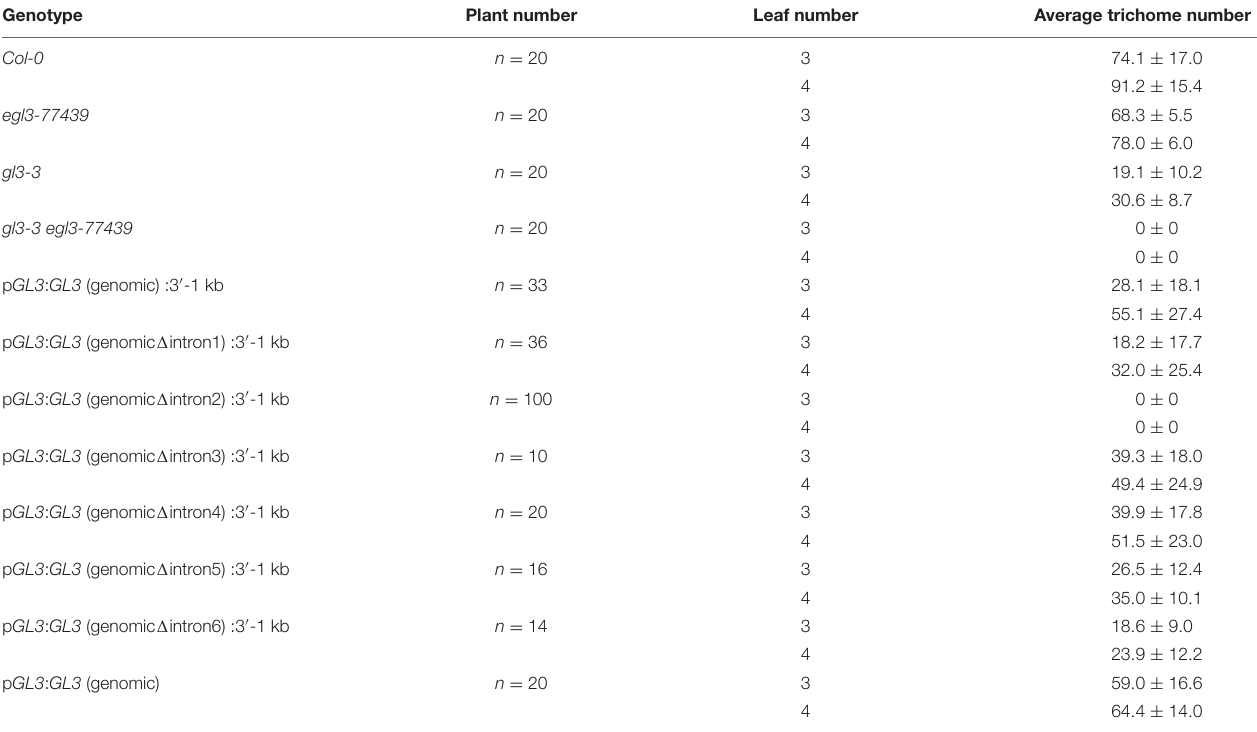
TABLE 1 | Trichome number of the third and fourth true leaf in gl3-3 egl3-77349 mutants transformed with different GL3 rescue constructs. Genotype Plant number Leaf